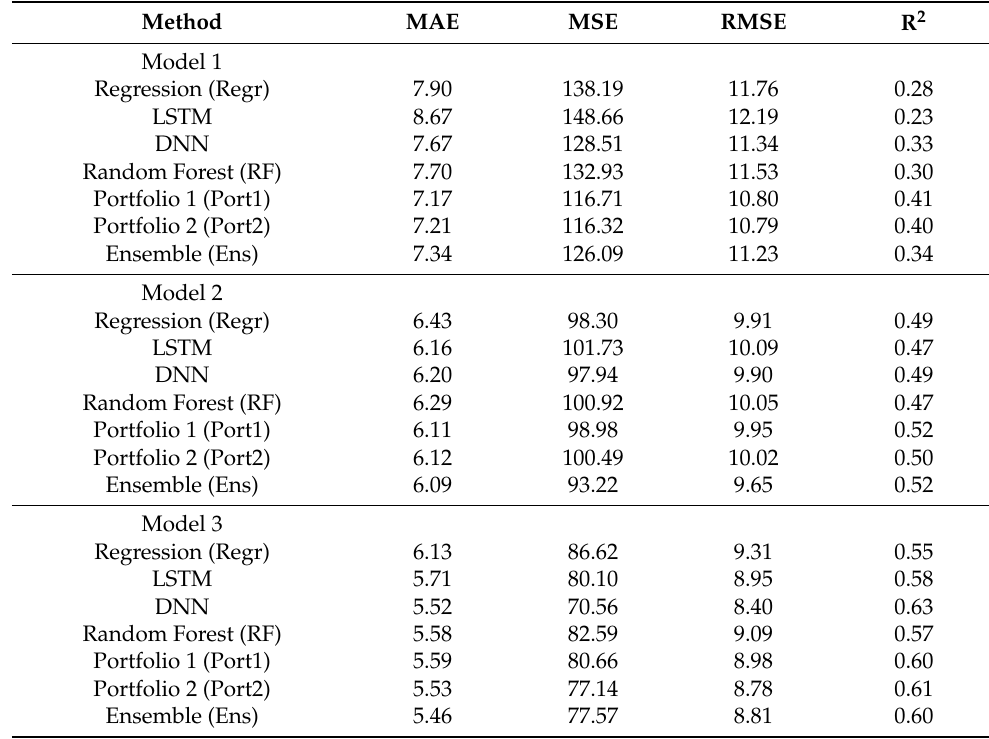
Table 4. Comparison of prediction measures of different models for the test sample.